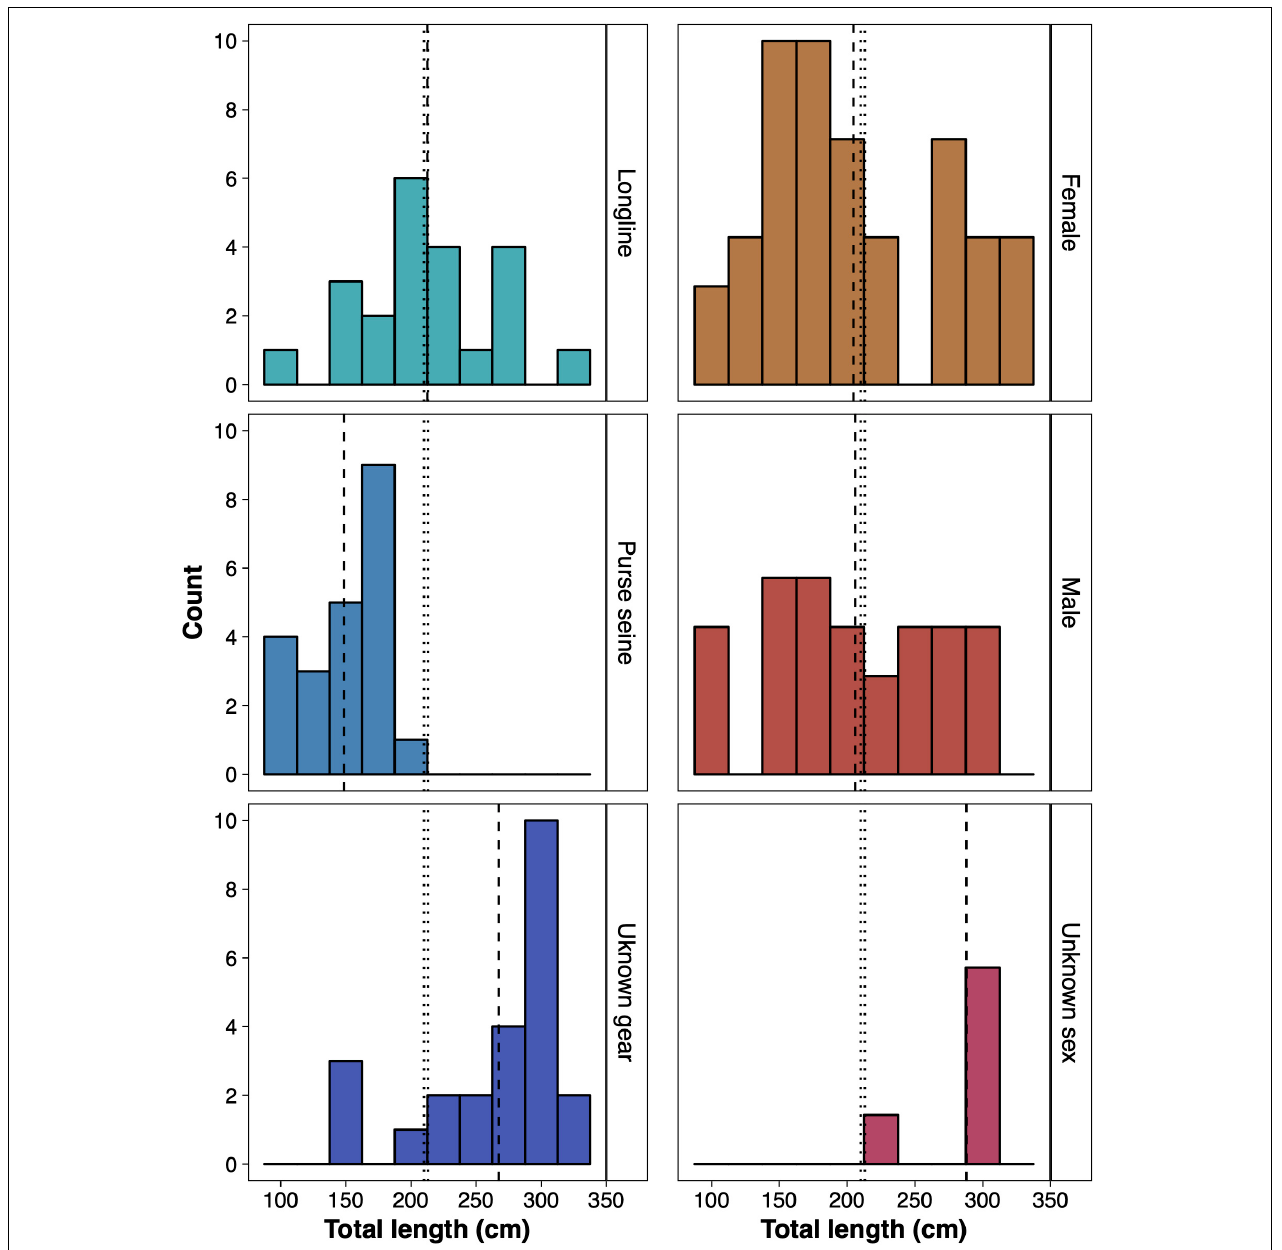
FIGURE 6 | The size distribution of silky sharks ( Carcharhinus falciformis ) caught around the Chagos Archipelago between November 1997 and November 2009 by purse seine, longline and unknown gear (left) and of female, male and individuals of an unknown sex caught by all gear types (right). Vertical dashed lines represent the mean lengths recorded by each respective group. Vertical dotted lines represent the estimated total length of maturity of female (210 cm) and male (212 cm) silky sharks (Joung et al.,